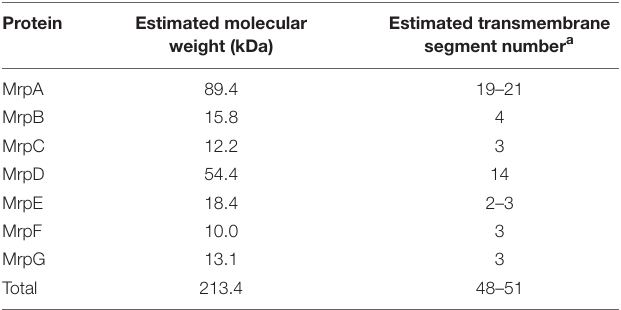
TABLE 1 | Molecular weight of each Mrp subunit derived from the B. pseudofirmus OF4 strain and the estimated number of transmembrane regions. Protein Estimated molecular weight